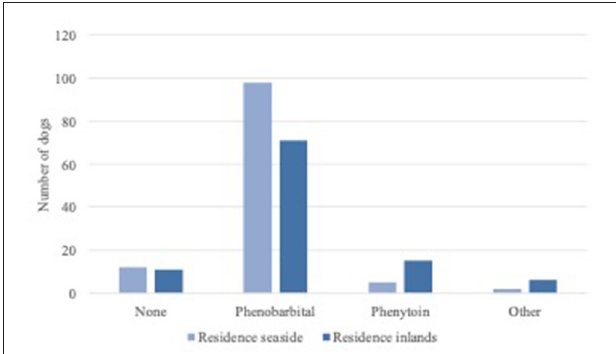
FIGURE 2 | Concurrent therapies of the dogs grouped by residence.